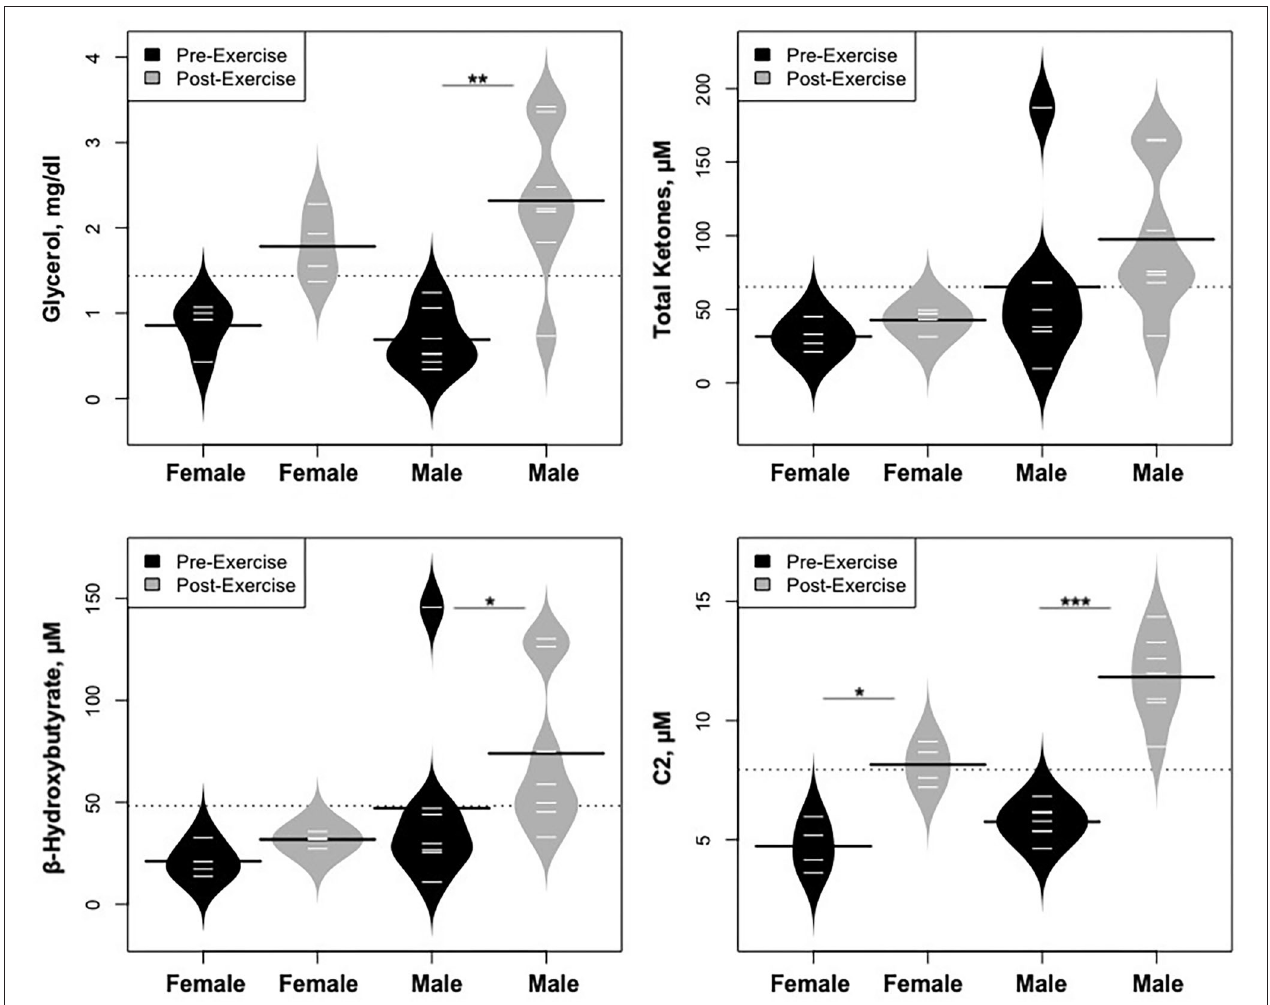
FIGURE 7 | Changes in metabolites related to lipolysis/FAO, stratified by sex. * p < 0.01, ** p < 0.001, *** p <